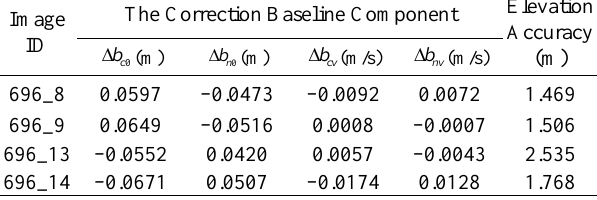
Table 4. Evaluation accuracy after baseline calibration